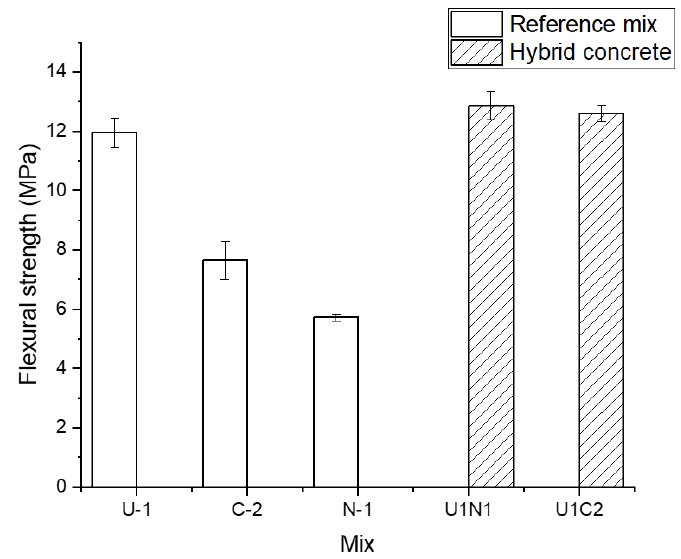
Figure 13 . The 28-day flexural strength results of test beams casted in two horizontal layers. In both cases, the UHPC concrete (U1) was located at the bottom of the bent beam.